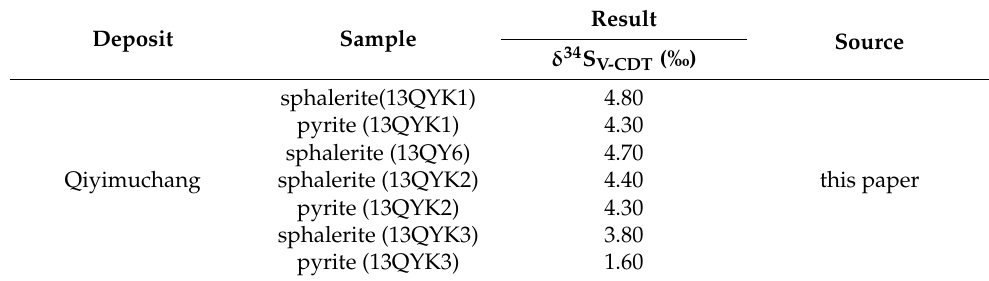
Table 2. Sulfur isotope data of ore minerals from typical lead–zinc deposits in Erguna metallogenic belt.